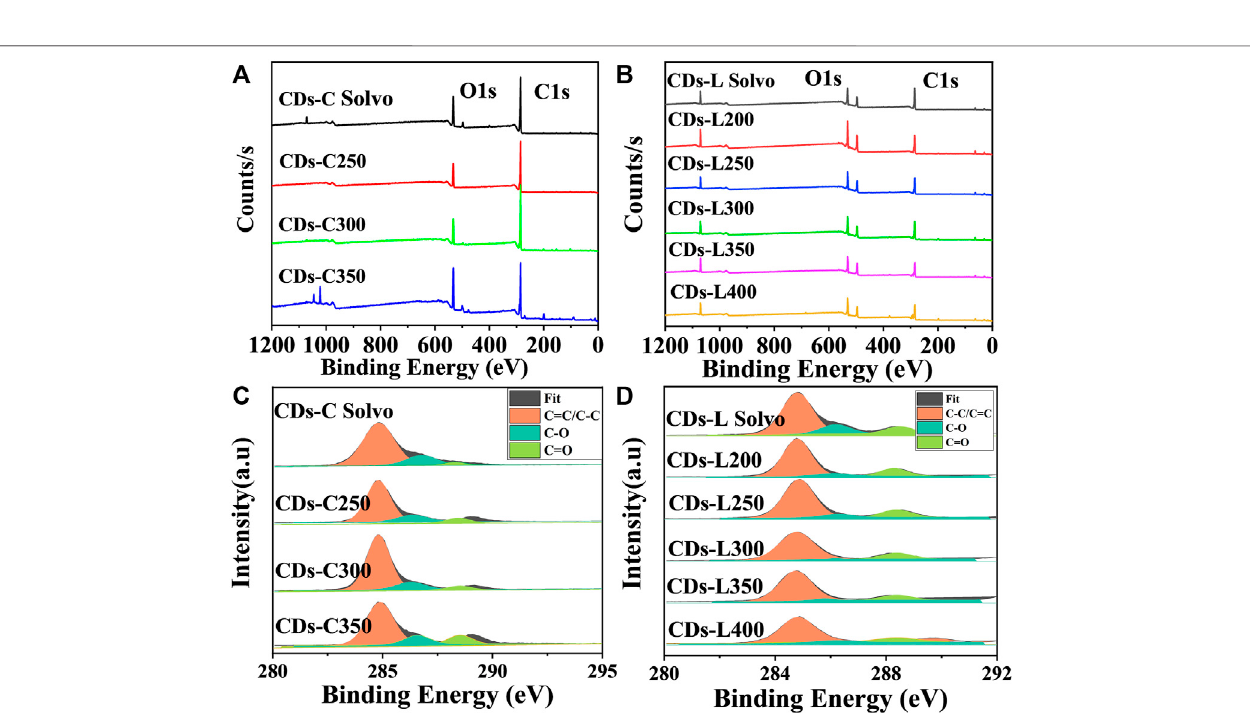
Frontiers in Chemistry |